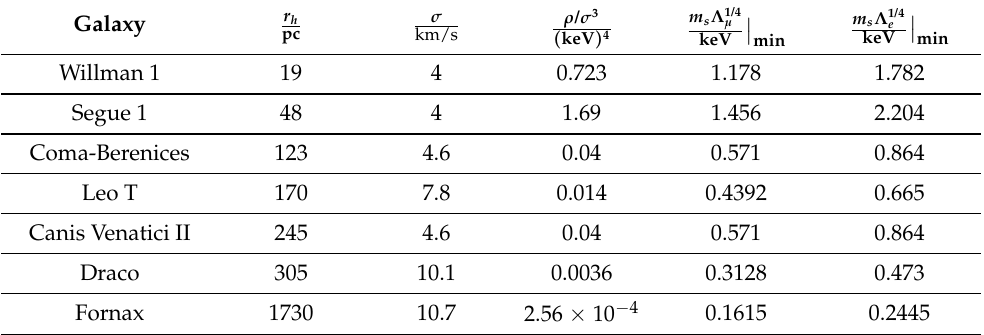
Table 2. Phase space data for compact galaxies and derived bounds on sterile neutrinos arising from pion